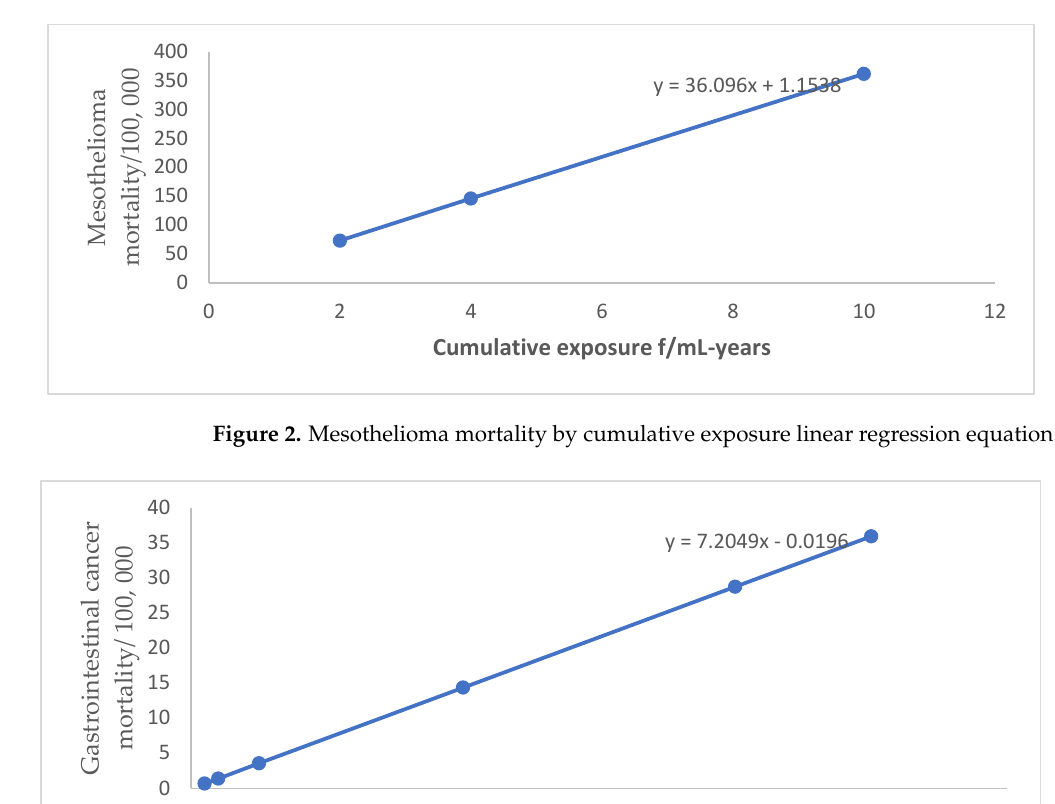
Figure 1. Lung cancer mortality by cumulative exposure linear regression equation.